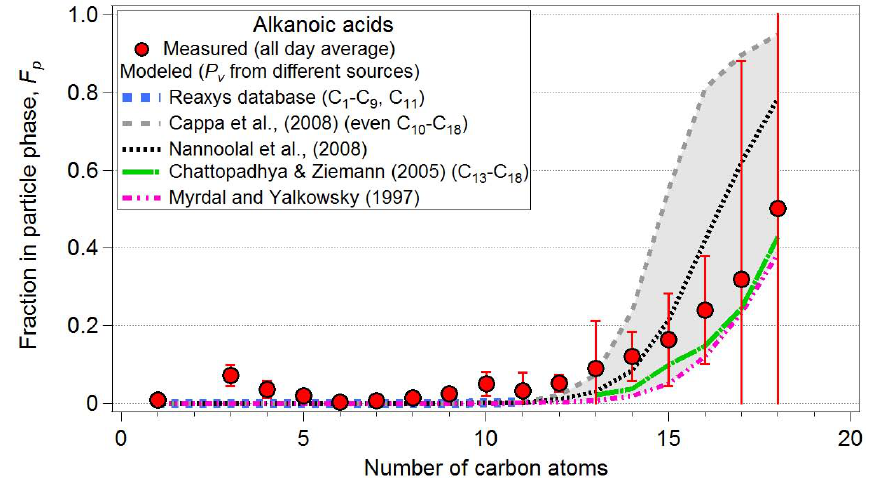
Fig. 3. Measured and modeled F p as a function of carbon number for alkanoic acids. Error bars represent measurement precision and variability due to ambient temperature and OA